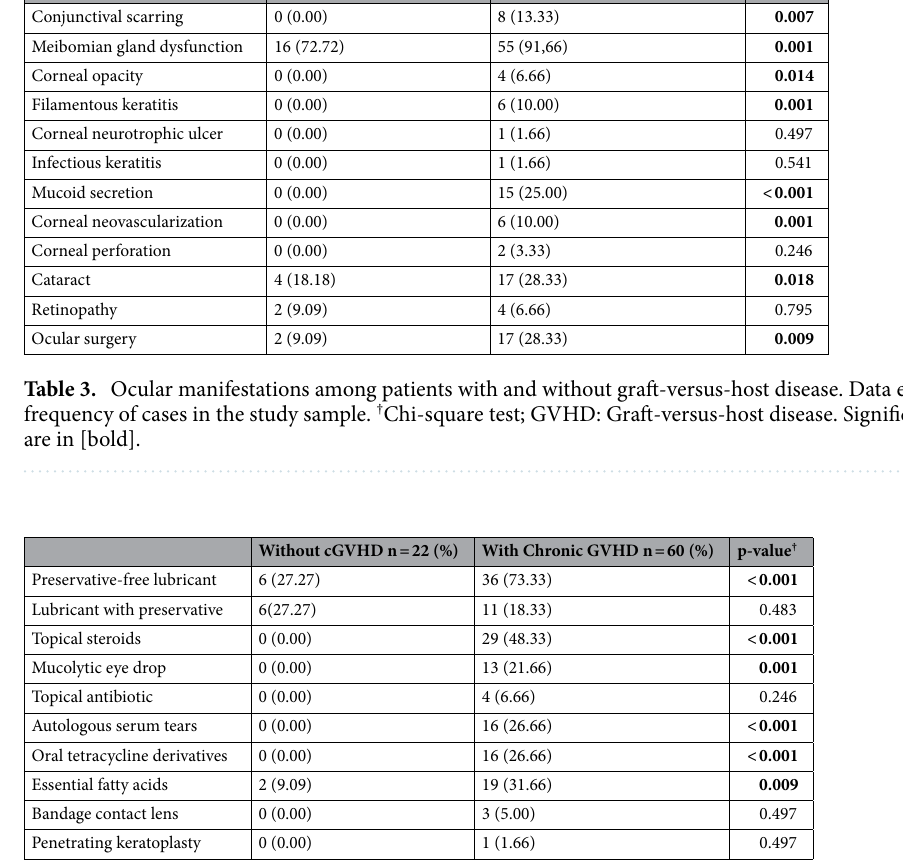
Table 4. Ocular treatments. Data expressed as mean ± standard deviation (median) or frequency. † Chi-square test; GVHD: Graft-versus-host disease. Significant values are in [bold].